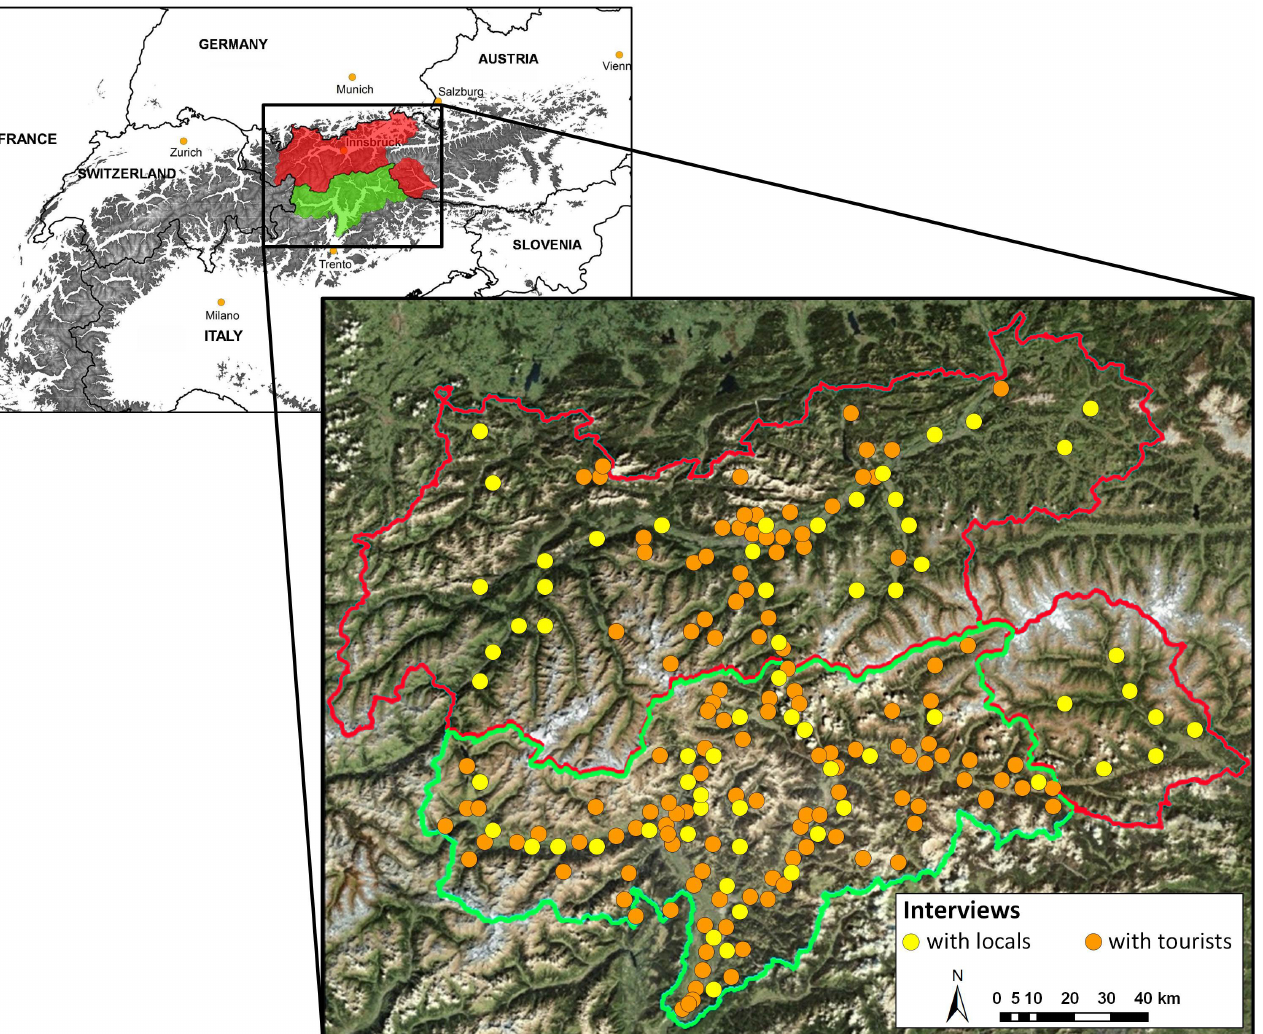
Figure 2. The study area spans the Province of Tyrol (Austria, in red) and the Autonomous Province of Bozen/Bolzano - South Tyrol (Italy, in green). Interviews with locals (yellow points) and tourists (red points) were carried out throughout the entire study